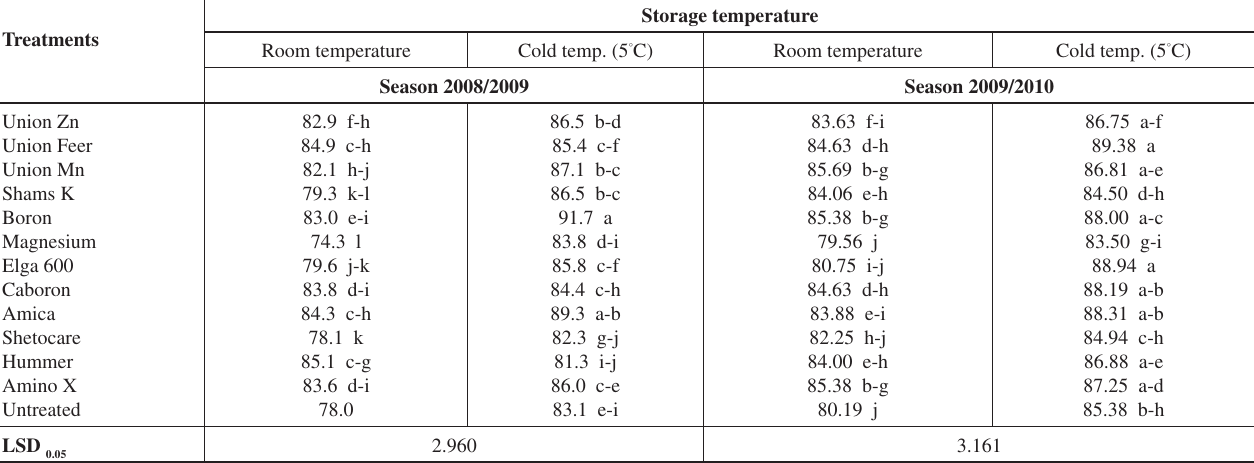
Table 8: Effect of the interaction between storage temperature and foliar application with commercial compounds on germination percentage of onion seeds during seasons of 2008/2009 and 2009/2010